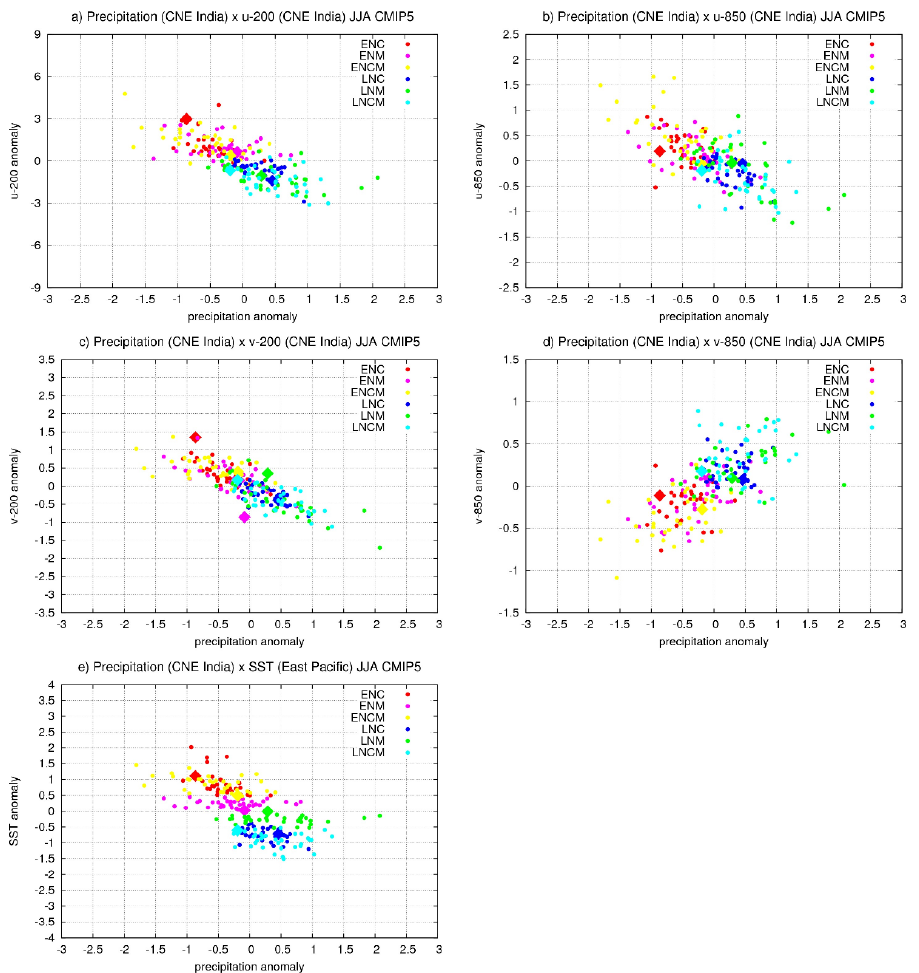
Figure 3. CNE Region: ISM precipitation (mm/day) vs. various fields. Precipitation vs. local atmospheric influence of wind (m/s) is shown for U200 ( a ), U850 ( b ), V200 ( c ) and V850 ( d ). Precipitation vs remote influence from East Tropical Pacific SST (°C) is also shown ( e ). Similar plots were drawn with remote forcing from the tropical Pacific, via wind or sea surface temperature (SST). If the model results indicated good correspondence or correlation between wind